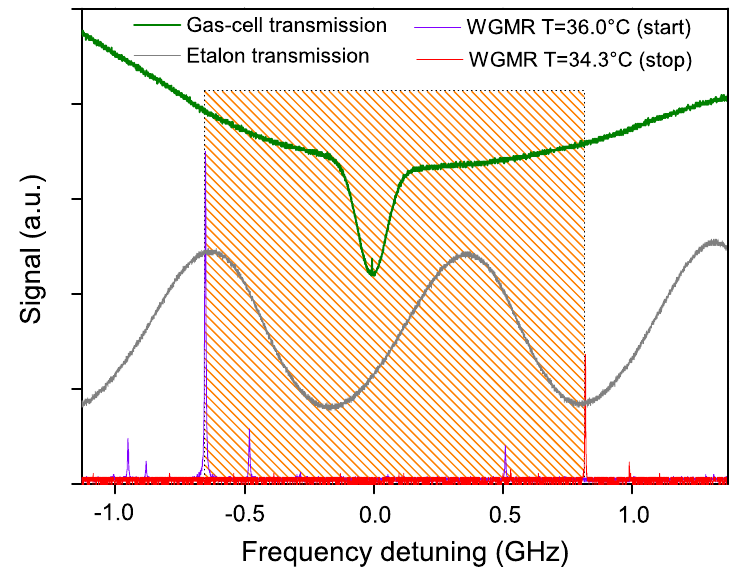
Figure 6. Representative frequency scan of the laser showing the tuning range in locking condition across the molecular transition. The horizontal scale represents the frequency detuning from the transition center (69285185(3) MHz as given by HITRAN). The green trace is the signal transmitted through the spectroscopic cell, and shows the molecular line (Doppler profile over pressure-broadened absorption from air); the purple and red traces are the main resonator modes to which the laser is locked, at the starting and ending points of the frequency scan; the gray trace shows the signal transmitted through the Ge etalon (1 GHz FSR). The hatched region shows the continuous tuning range achieved in locking condition only by acting on the resonator